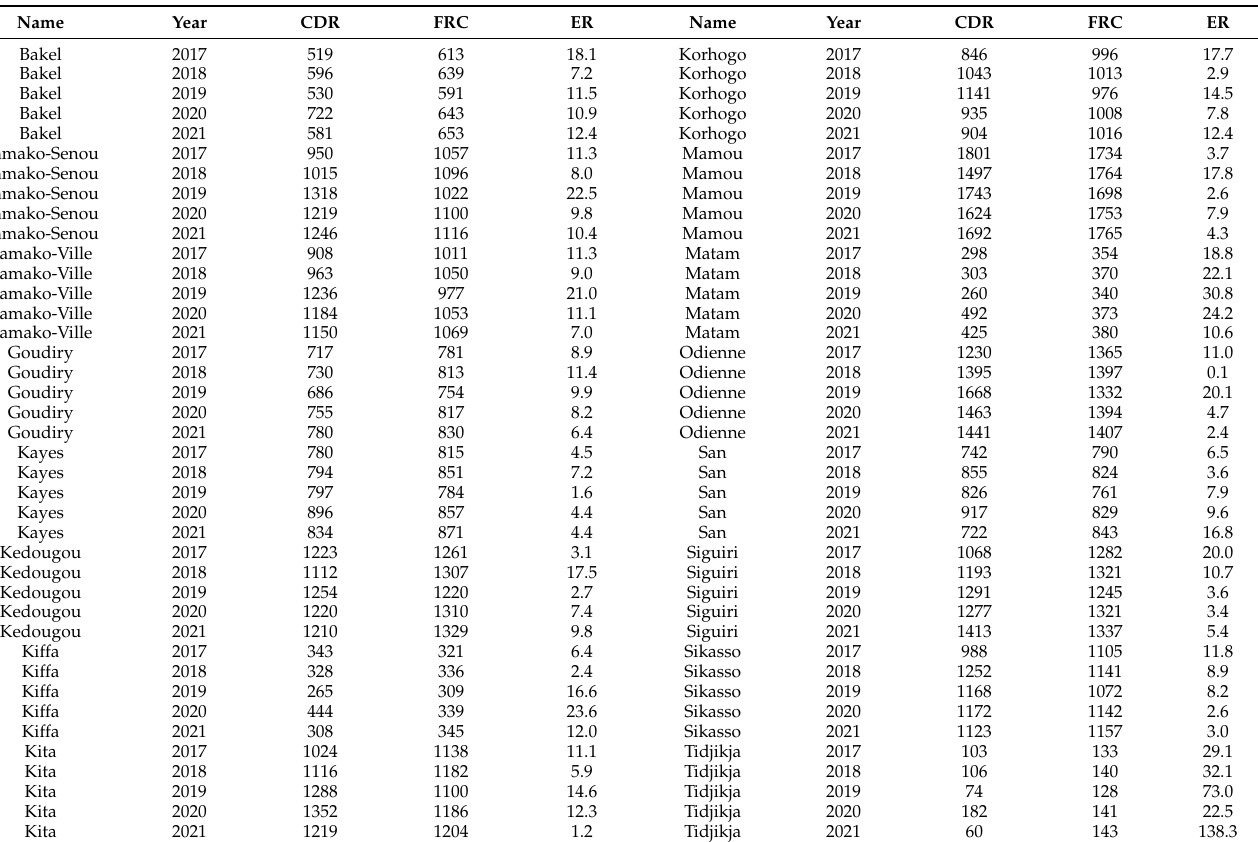
Table A2. Validation of the forecasts (FRC) with PERSIANN-CDR rainfall (CDR) at pixel-to-point from the last 5 years (complement of Table